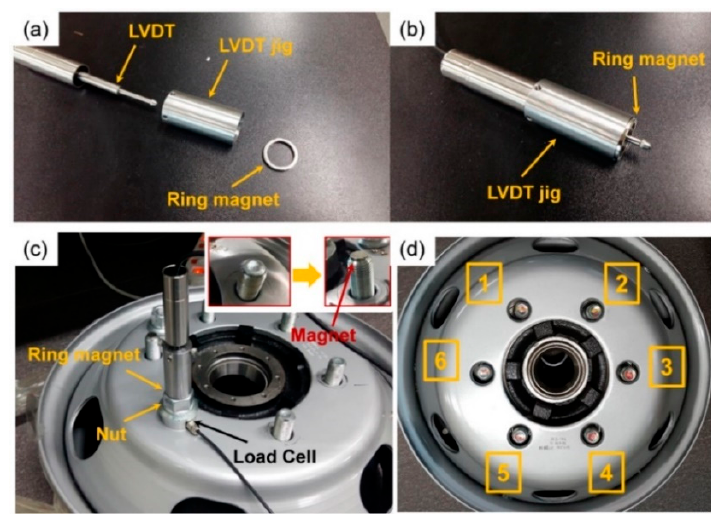
Figure 3. ( a ) Components of the L-PMS: LVDT, customized jig, and ring magnet, ( b ) assembled L-PMS, ( c ) experimental setup, and ( d ) bolt numbering.